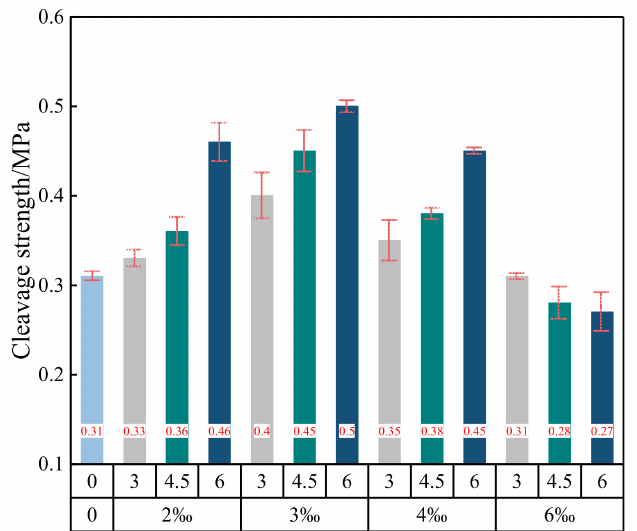
Figure 7. Change of splitting strength with